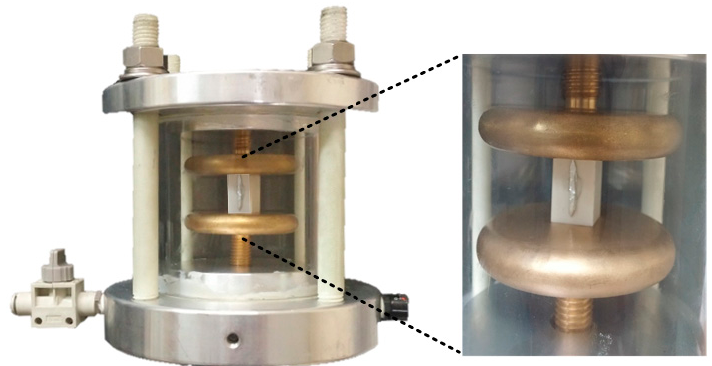
Figure 2. PD cell for a particle on spacer (POS).